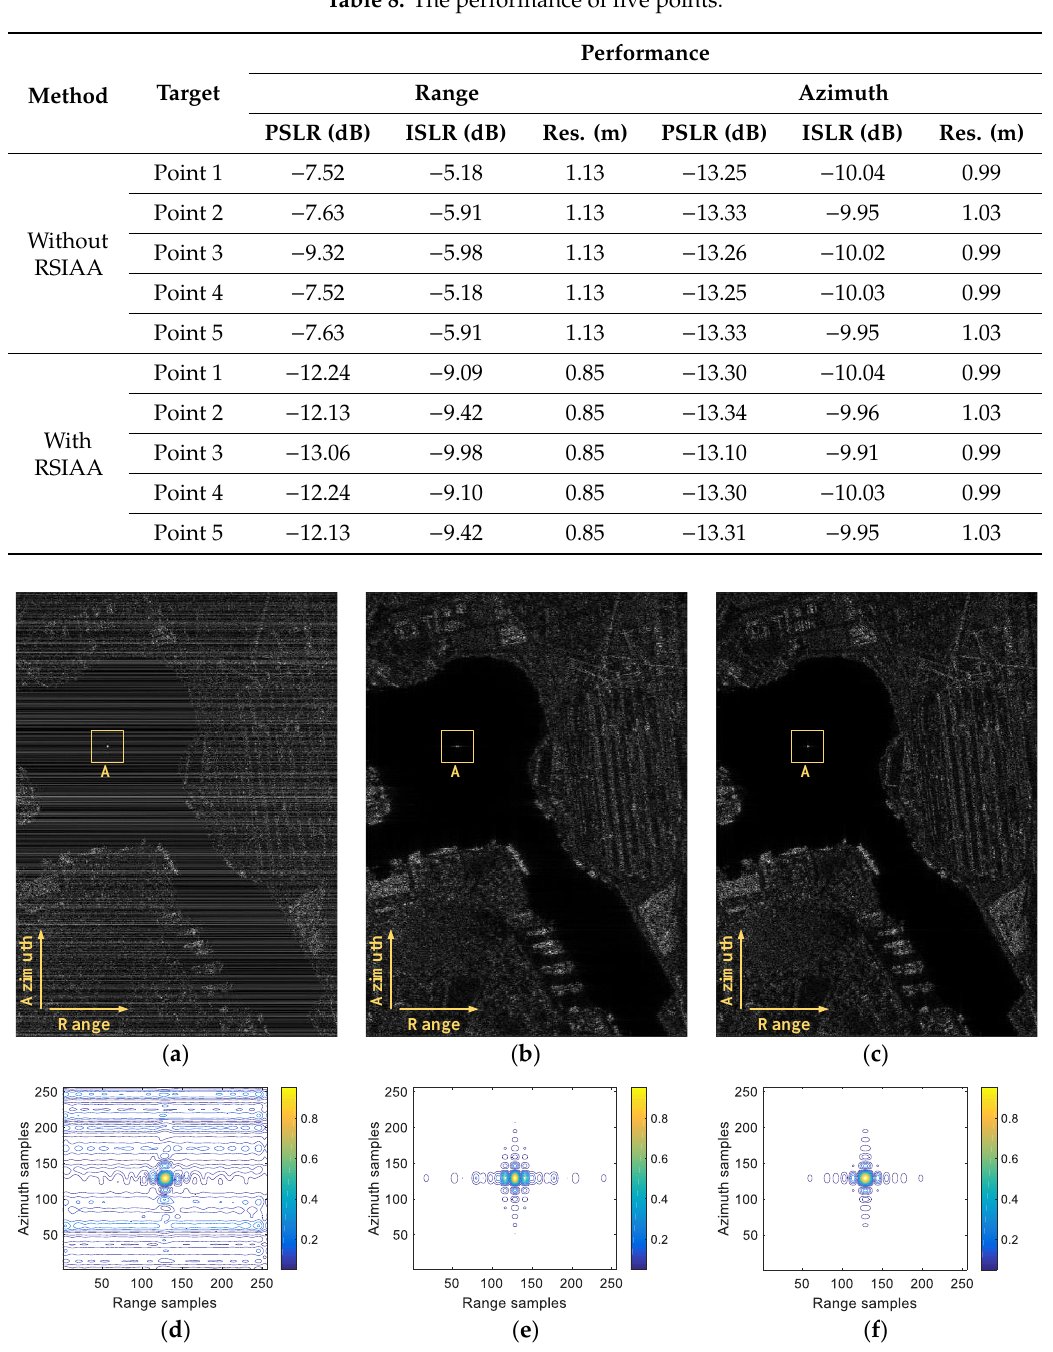
Figure 12. Simulation results of the distributed scene. ( a ) The focused SAR image with RFI; ( b ) the focused SAR image without the RSIAA; ( c ) the focused SAR image with the RSIAA; ( d )-( f ) contour plots of the point target in the marked area of ( a )-( c ). Table 9. Measured imaging performances of the point target in the marked area A.